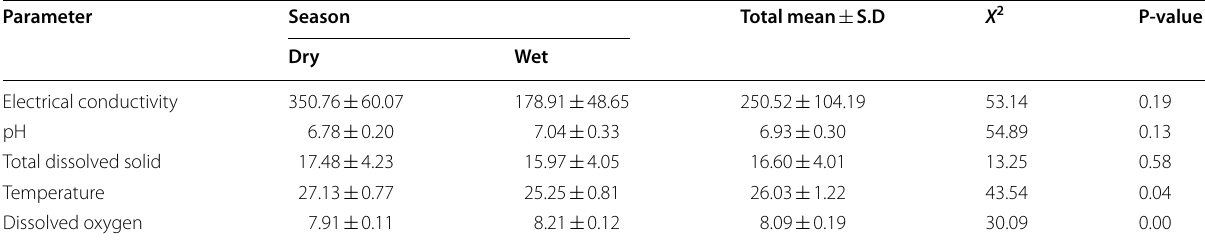
S.D) of Anopheles larvae ±